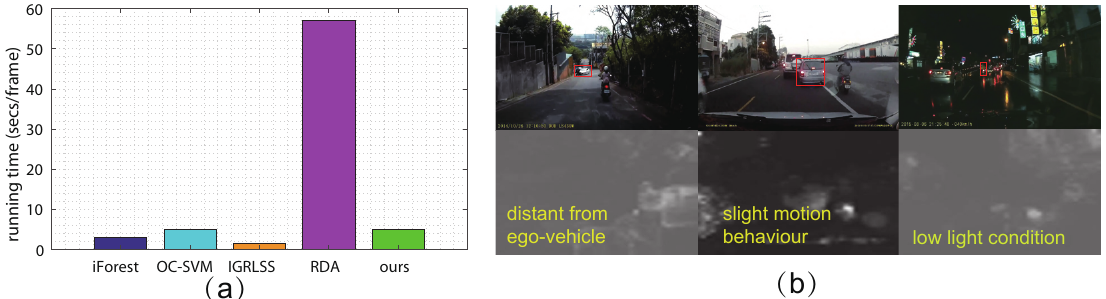
Figure 9. Discussion of for efficiency and failure situations. ( a ) demonstrates the efficiency comparison; and ( b ) shows the situations of anomaly distant from ego-vehicle, slight motion behavior, and imperceptible anomaly with low light condition, coupled with the detection results by